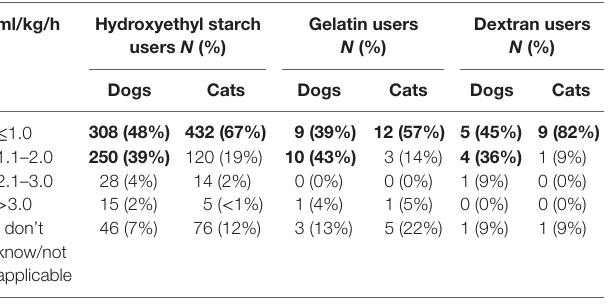
Frequently reported doses ( > 25% of respondents) are given in bold font.